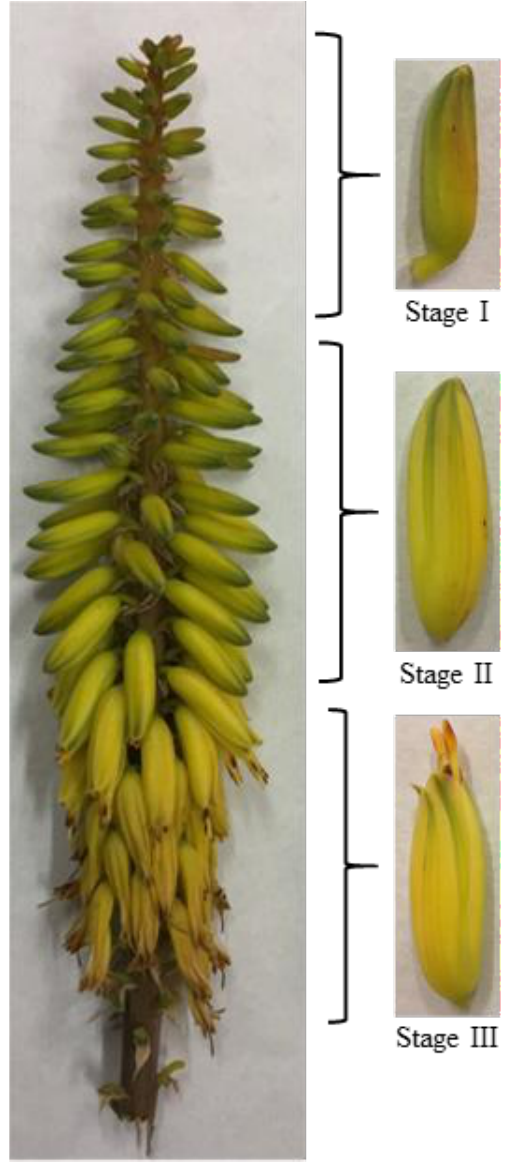
Figure 1. Inflorescence of aloe plant and classification of Aloe vera flowers according to their state of development: stage I (immature flowers shorter than 2 cm), stage II (mature, but flower buds still closed, flowers between 2–4 cm), and stage III (mature, with flowers buds opened, more than 4 cm).